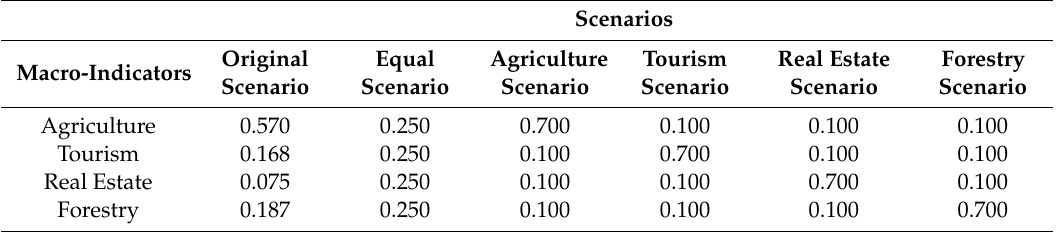
Table 10. Determination of scenarios changing the weights of landscape indicators.